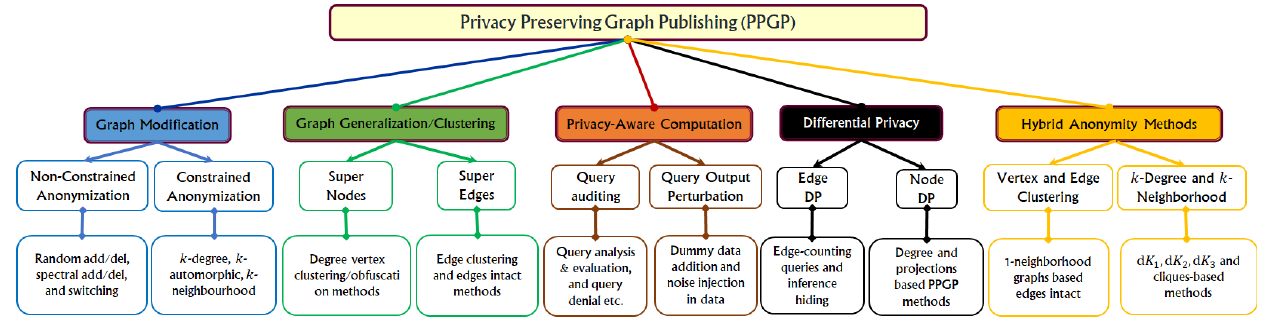
Figure 10. Research tracks in privacy preservation of social network